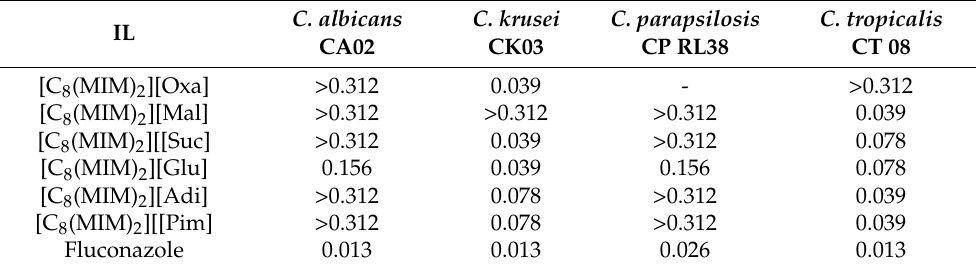
Table 1. MICs (in mM) of DILs and Fluconazole against Candidas , after 24 h. IL